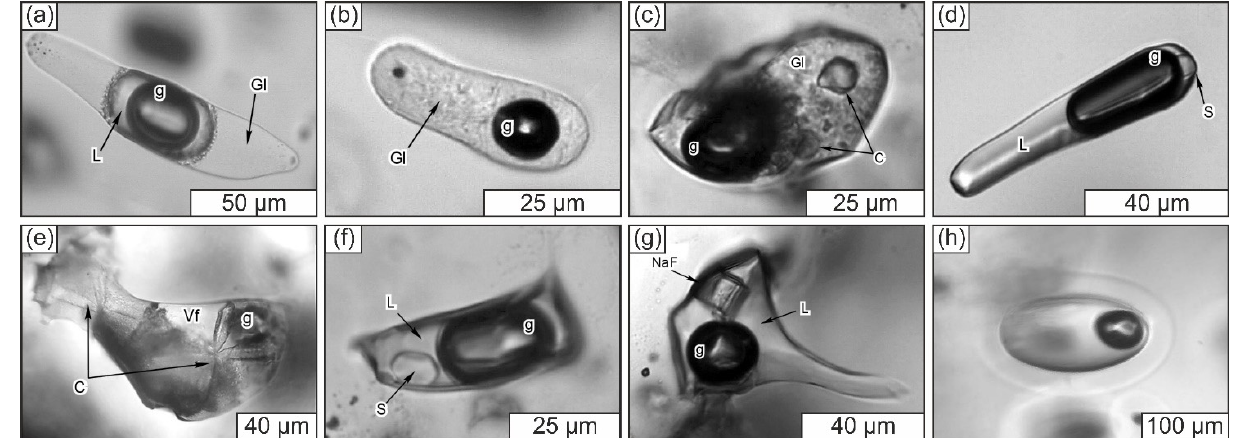
Figure 2. Examples of synthetic inclusions of hydrosilicate and associated fluids. ( a – g ) Quartz-hosted inclusions obtained in experiments at 800 °C and 2 kbar in a system H 3 BO 3 -NaF-SiO 2 -H 2 O [10] (reproduced with a permission from Russian Geology and Geophysics). NaF: villiaumite crystal; S: sassolite crystal (H 3 BO 3 ); c: crystals of other minerals; L: aqueous solution; g: vapour bubble; Gl: gel-like vitreous phase (quenched hydrosilicate fluid); Vf: gel-like viscous phase (quenched hydrosilicate fluid). ( a – d ) Inclusions containing hydrosilicate fluids ( a – c ) and aqueous solutions ( a , d )